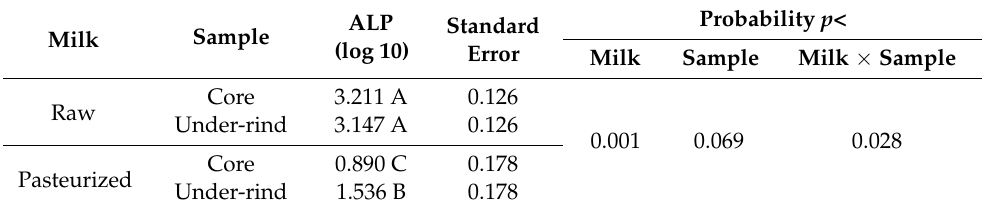
Table 2. ALP values in different zones of the cheese